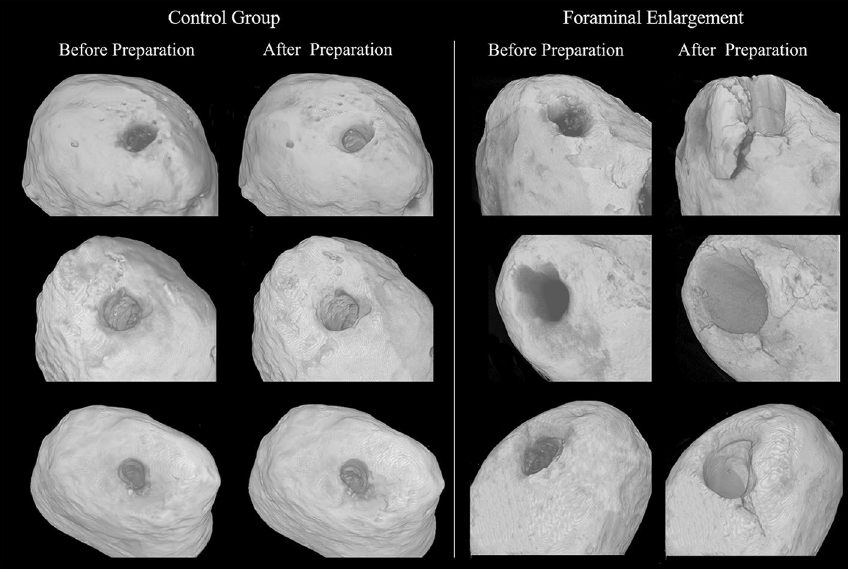
Figure 3. 3D reconstruction of nano-CT showing the presence of microcracks and apical deformations after foraminal